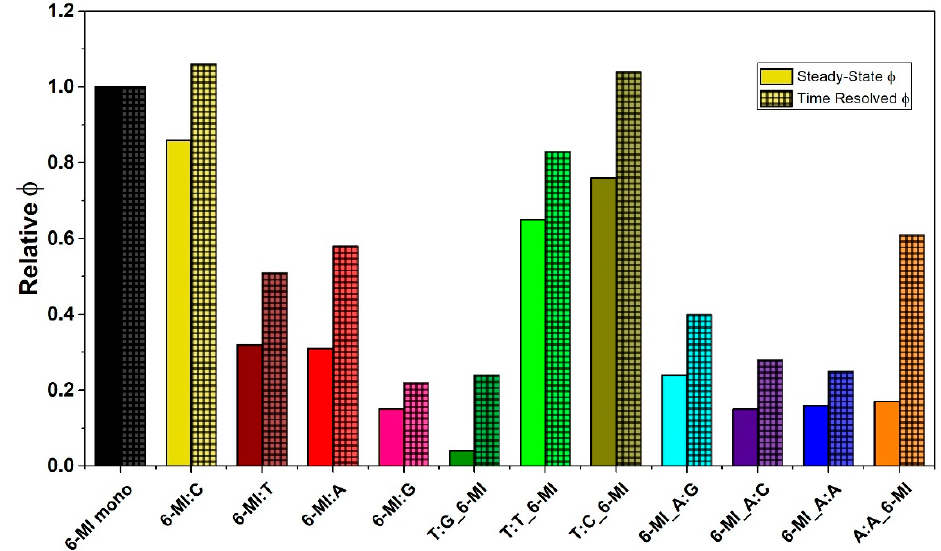
Figure 2. Steady-state and time-resolved 6-MI quantum yields of the mismatched DNA duplexes. The steady-state ( φ relSS ) and time-resolved quantum yields ( φ relTR ) are reported relative to 6-MI monomer quantum yield, which is normalized to 1. Values are given in Table S3. Steady-state quantum yields are shown in solid bars and time-resolved quantum yields are shown in hatched bars. T:T_6-MI, T:C_6-MI and 6-MI:C exhibit the highest quantum yields signifying a lack of dynamic quenching.